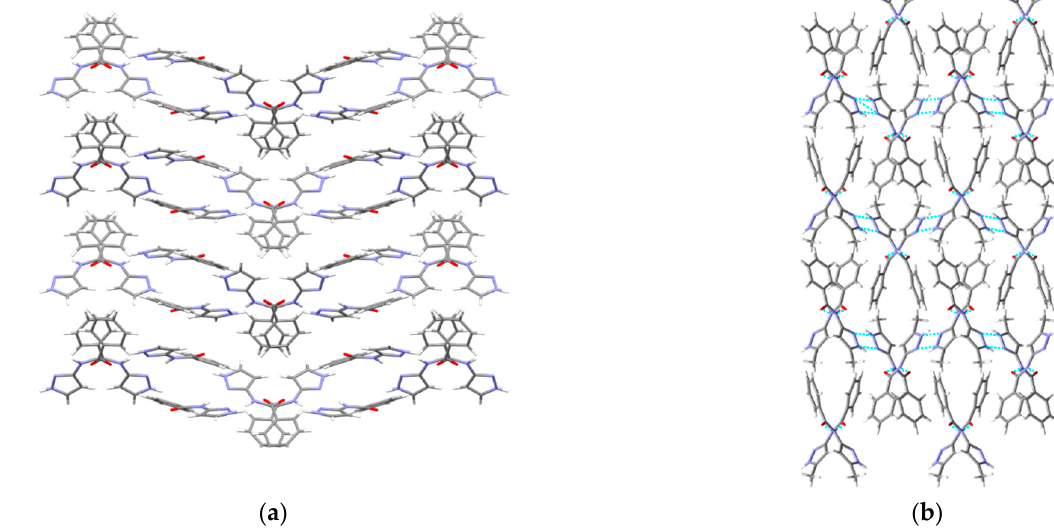
Figure 8. Hydrogen-bonding observed in the crystal structure of ( a ) P7 and ( b ) P8 along the crystallographic a -axis.